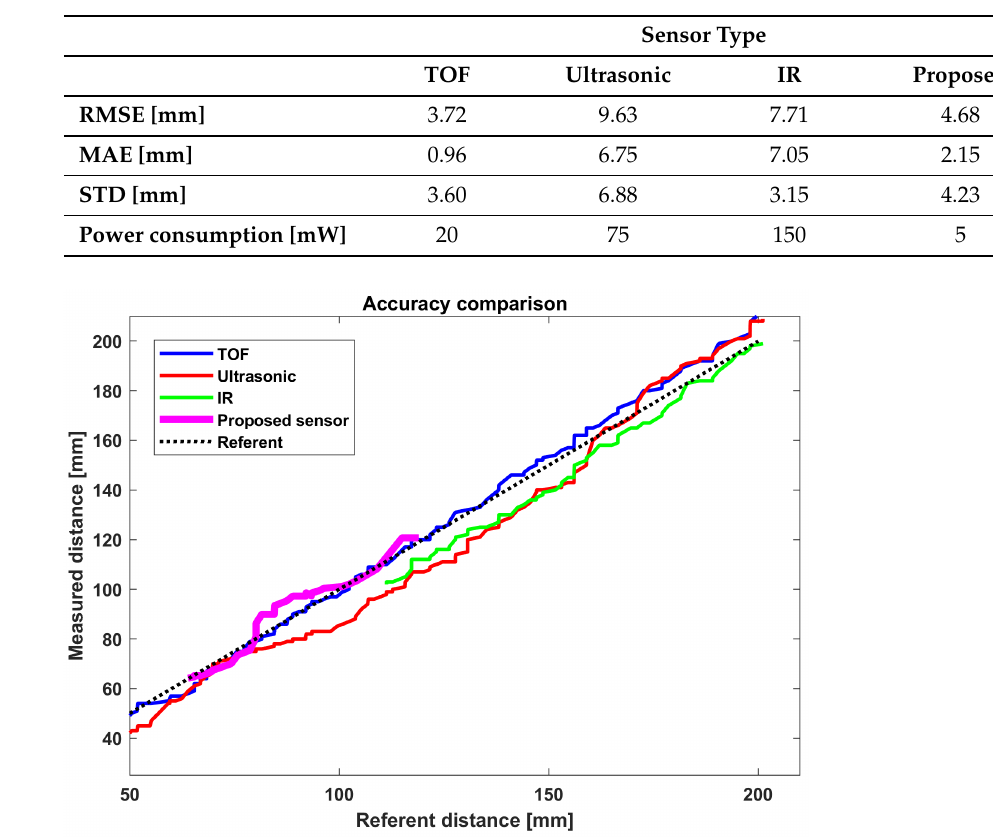
Table 1. Measured characteristics and power consumption for sensors used in the sensor subsystem.